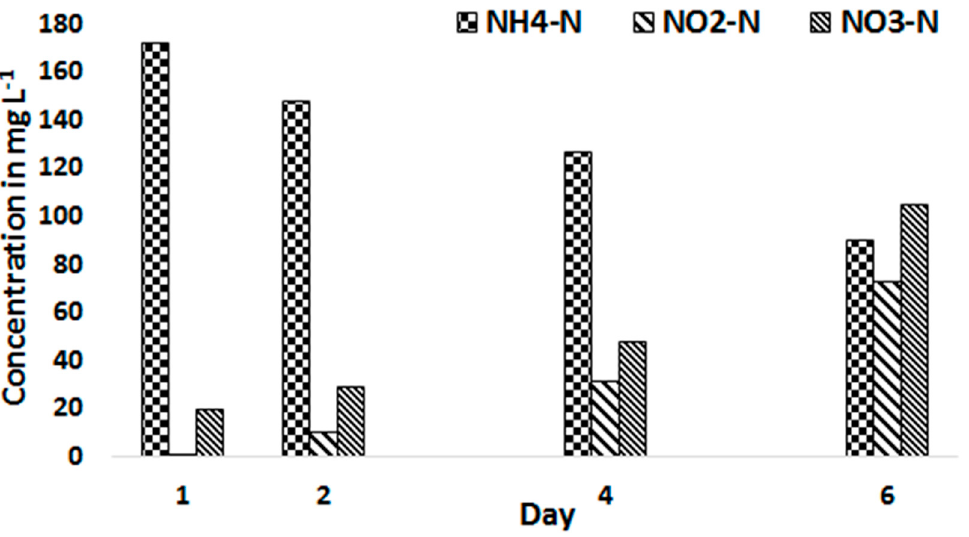
Figure 5. Change in NH 4 -N, NO 2 -N, and NO 3 -N concentrations in the substrate during the 6th day feeding period.